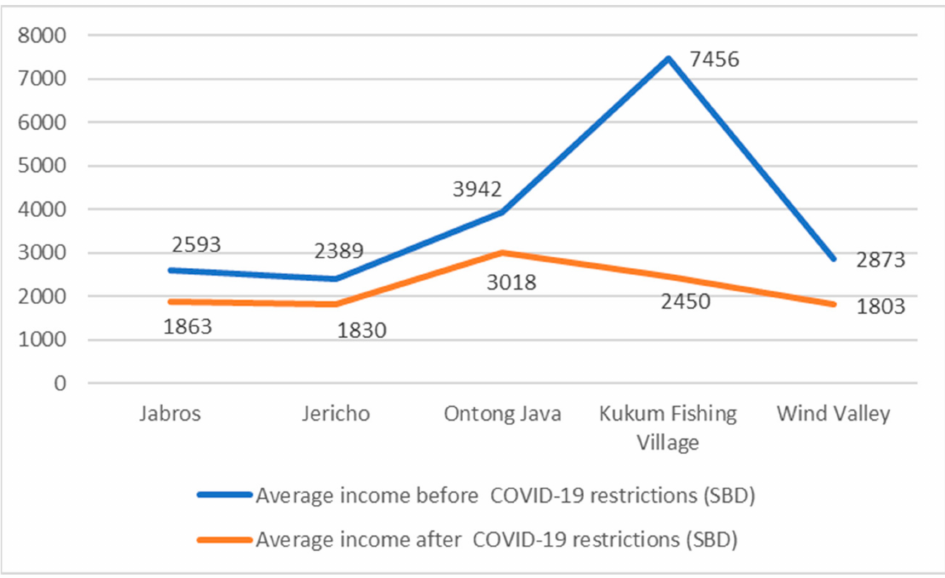
Figure 3. Average income before and after COVID-19 restrictions by settlement (Data from